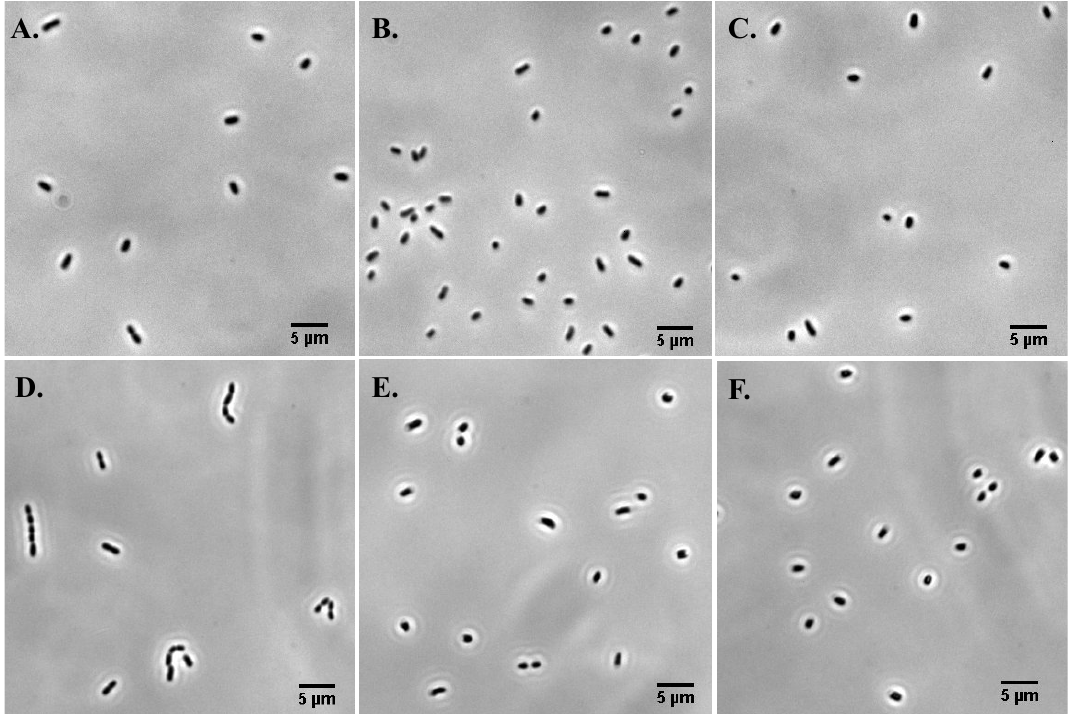
Figure 2. Representative images of E. coli at MgSO 4 concentrations of ( A ) 2 mM, ( B ) 0.41 M, ( C ) 0.83 M, and ( D ) 1.25 M, respectively. The images were taken when the sample OD 600 = 1. ( E , F ) are the images of the cells grown for 15 h in MgSO 4 concentrations of 1.66 M and 2.07 M,